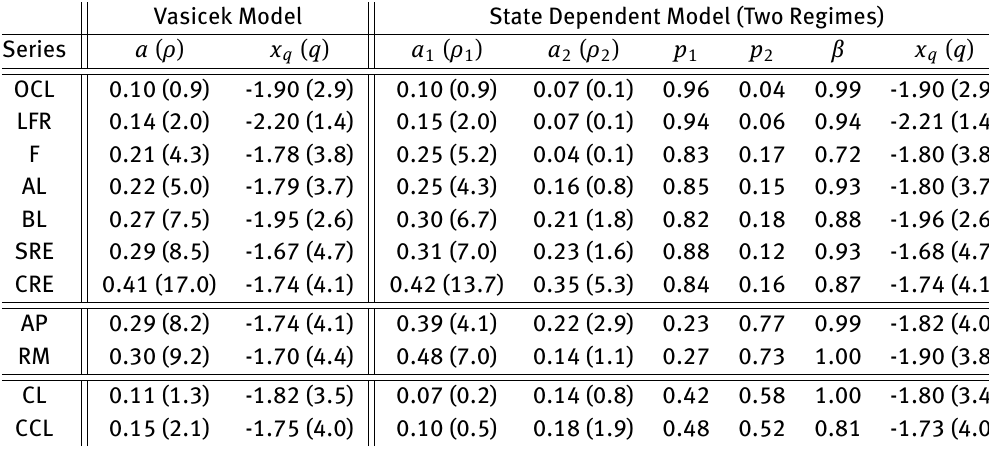
Table 5.3: Parameter estimates for the Vasicek model and the state dependent model with two regimes. Correlations and de- fault probabilities are reported in percentage points (i.e. the reported values of q are actually 100 q % , etc. for ρ